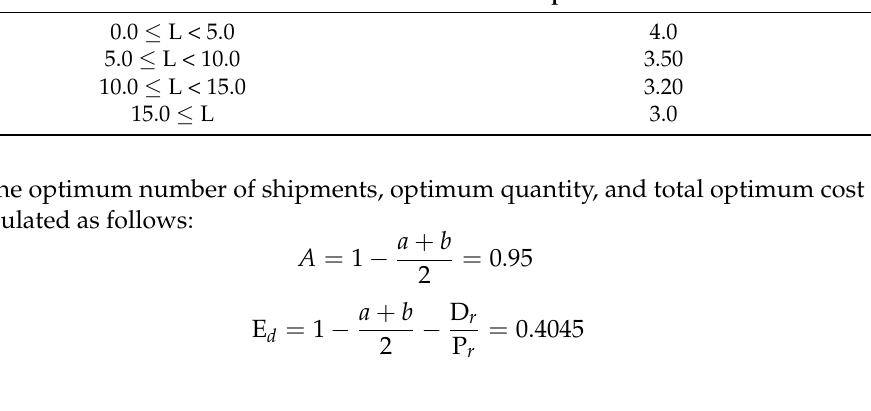
Table 5. Items unit transportation costs structure. Series of